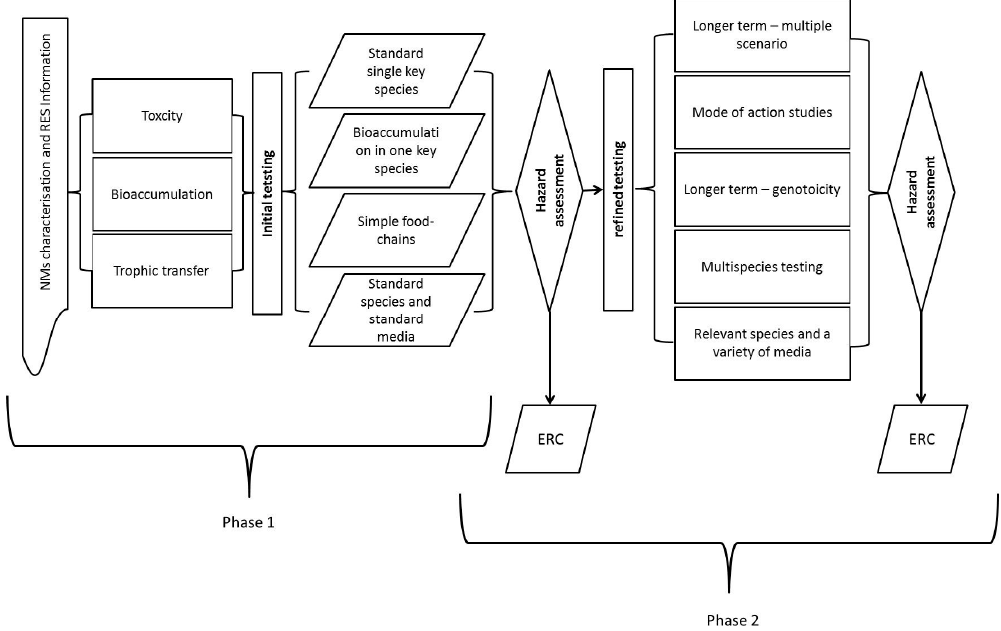
Figure 8. Schematic representation of the hazard testing regime for NMs proposed in MARINA, covering initial (always required) testing and refined testing. RES = Relevant Exposure Scenario; ERC = Environmental Risk Characterisation.